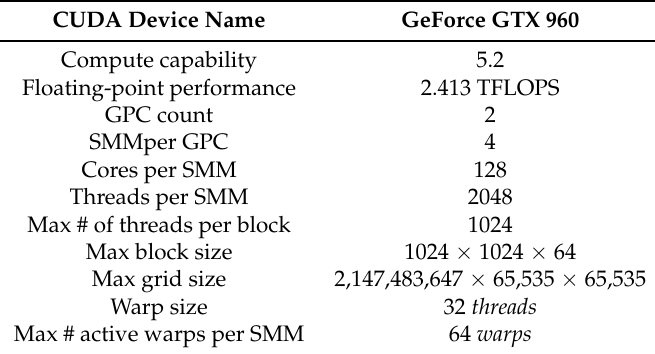
Table 1. Device structure-related